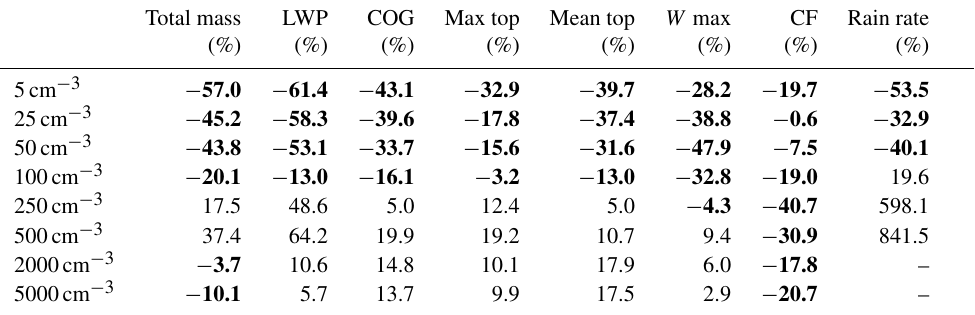
Table 1. Change (in %) in key variables between the mean values in the last period of the simulations and the first period. Negative values are presented in bold. Total mass LWP COG Max top Mean top W max CF Rain rate (%) (%) (%) (%) (%) (%) (%) (%) 5cm − 3 − 57.0 −